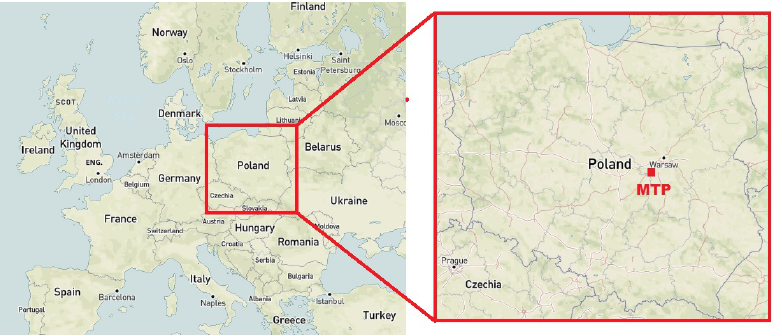
Figure 1. A map showing the location of the municipal treatment plant where the research was conducted.